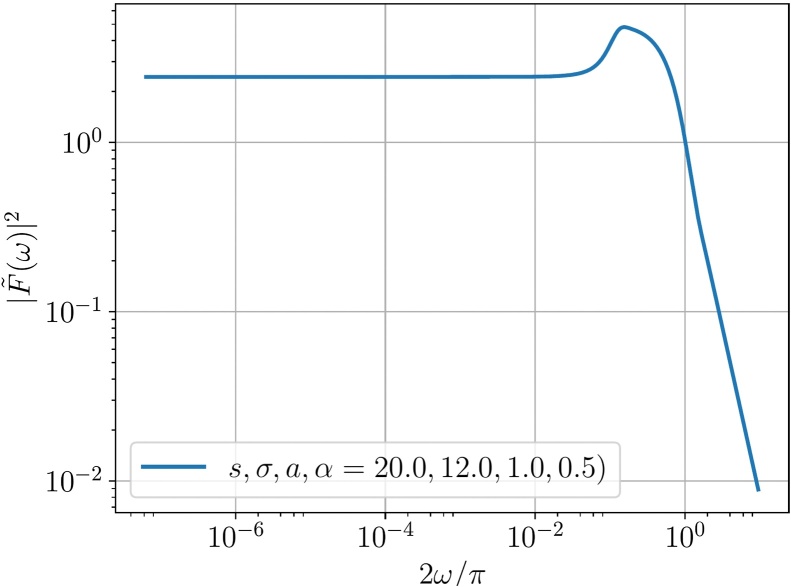
Power spectrum of a theoretical square signal with subsequent square wavelets at varying separations (see Eq. (A.3)). These inter-wavelet distances follow the normal distribution N(s, σ). The widths of the wavelets are also normally distributed (N(a, α)).